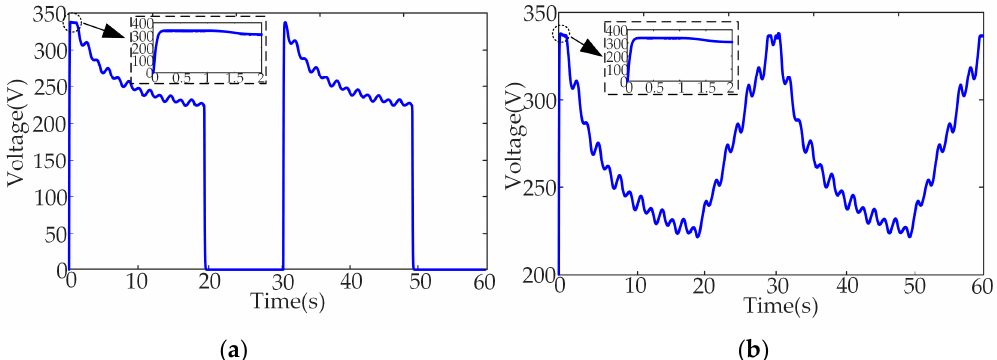
Figure 10. The phase voltage waveforms under regular incident waves. ( a ) Phase voltage of G1; ( b ) phase voltage of G2.